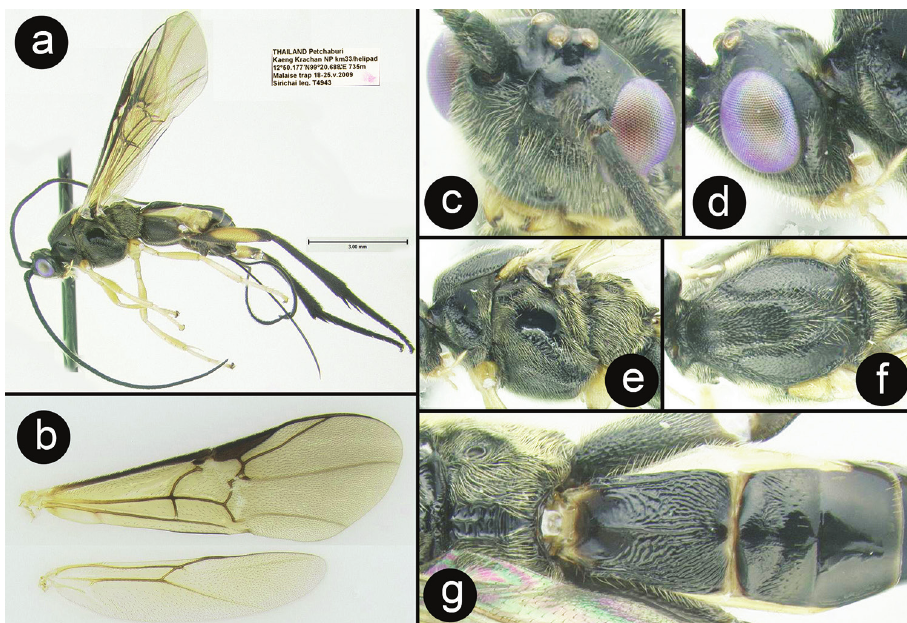
Figure 5. Chimaeragathis chrysoma holotype female: a lateral habitus b wings c anterolateral head d lateral head e lateral mesosoma f dorsal thorax g propodeum and metasomal terga 1-3.